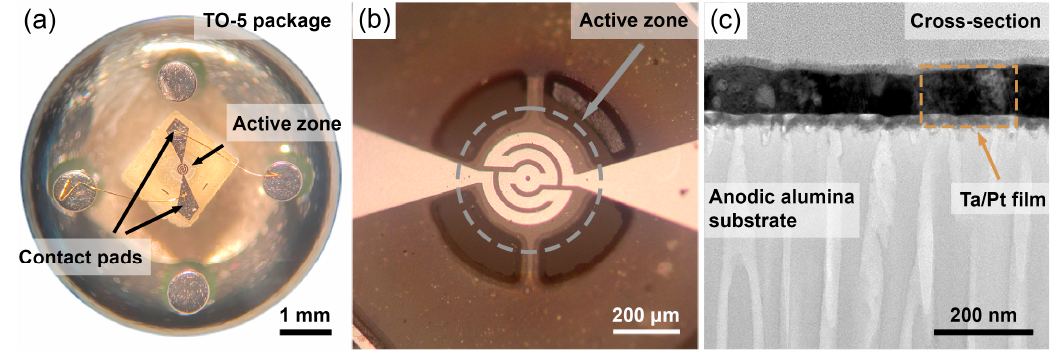
Figure 1. Microheater mounted in TO-5 package ( a ). Optical image of the active zone of the microheater ( b ). Cross-section of a Ta/Pt thin film on a porous anodic aluminium oxide substrate ( c ).